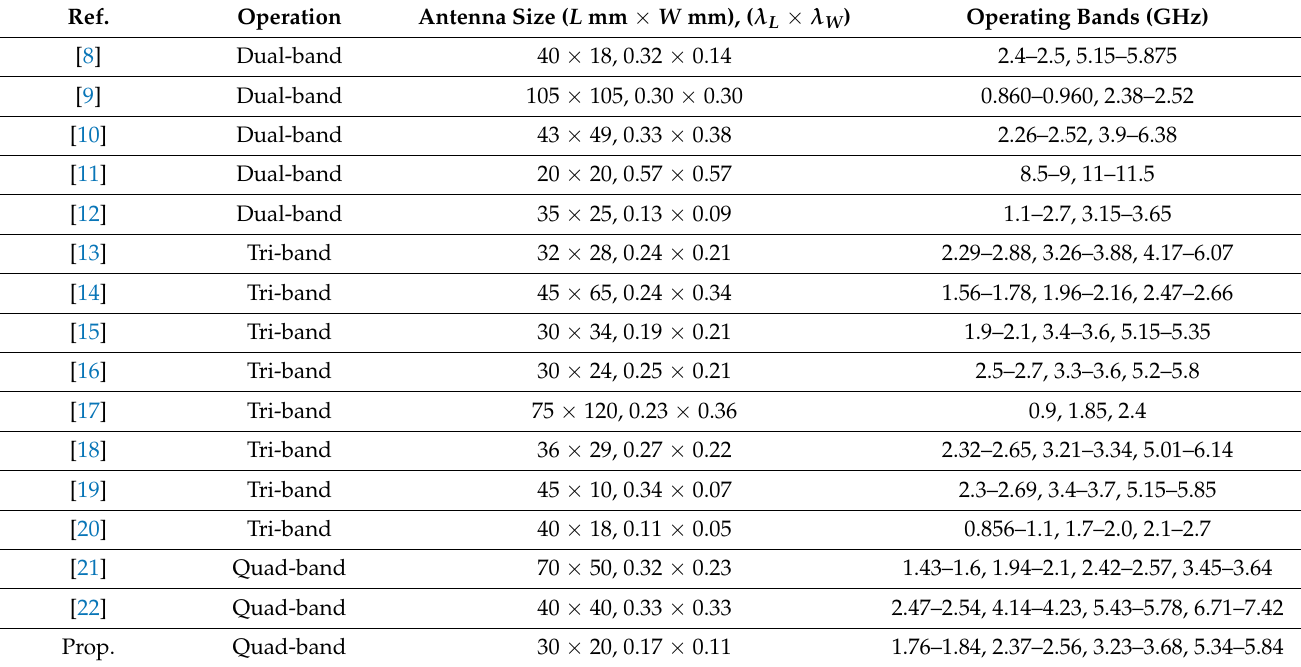
Table 4 compares the proposed antenna element with the existing dual-band, triple- band, and quad-band antennas. Table 5 shows a comparison of the proposed MIMO antenna and existing MIMO antennas for IoT applications. The proposed antenna has a compact size, moderate gain, and omnidirectional radiation patterns in the operating bands, making it suitable for IoT applications. Table 4. Comparison of existing monopole antennas and the proposed quad-band antenna. Ref.